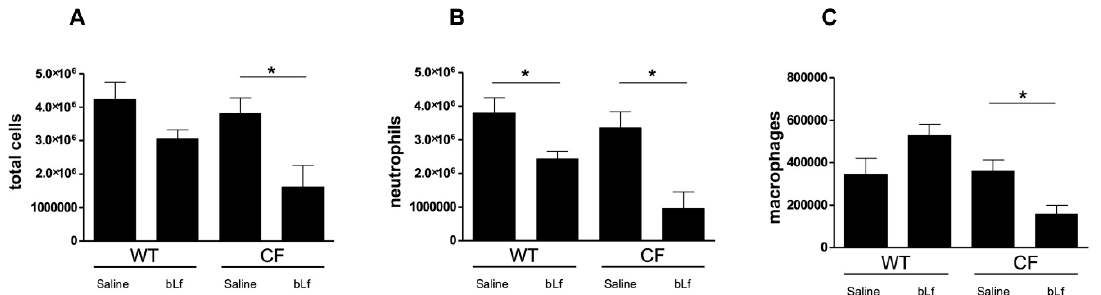
Figure 3. Total cell ( A ), neutrophils ( B ) and macrophages ( C ) counts in BALFs of WT and CF mice after 7 treatments with aerosol administration of 50 µ L sterile saline or 200 µ g / 50 µ L bLf, evaluated 6 days after challenge (see Materials and Methods section for details). Error bars: standard error of the mean. Statistical significance is indicated as follows: *: p < 0.05 (Mann-Whitney U